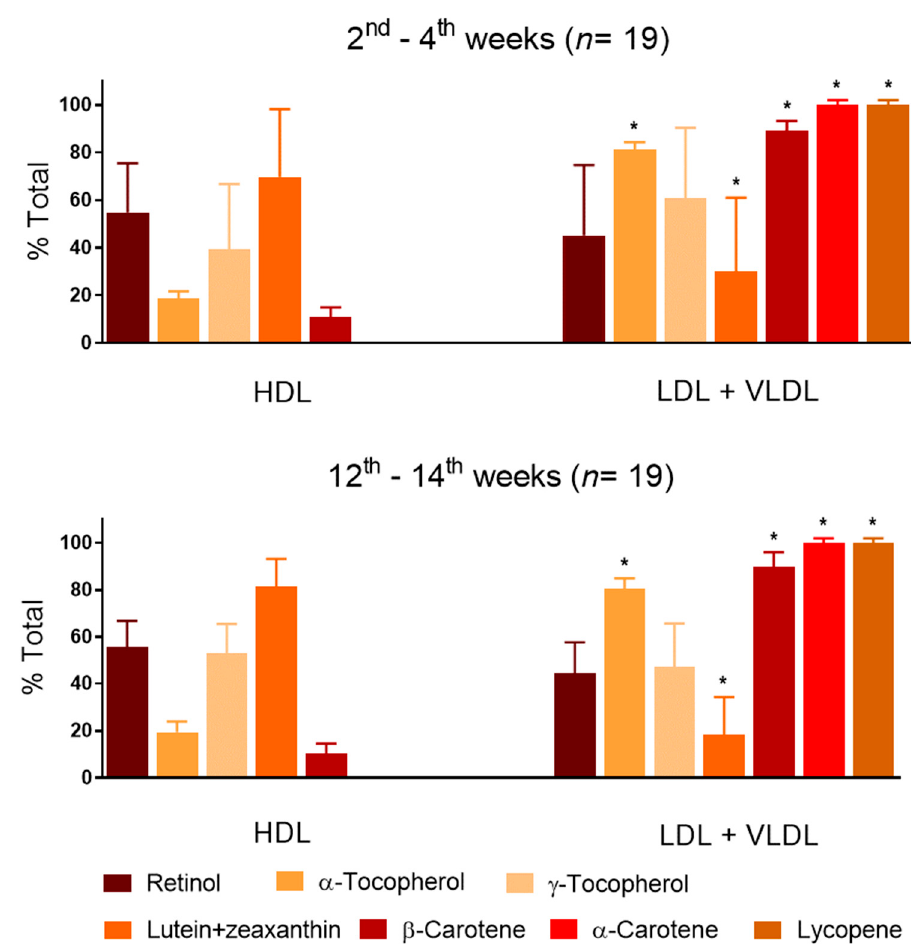
Figure 1. Distribution of fat-soluble vitamins in blood serum lipoprotein fractions in early- and mid-lactation. * Significantly different from the contents (%) in the HDL fraction (paired t -test; p < 0.05). Error bars represent standard deviations.